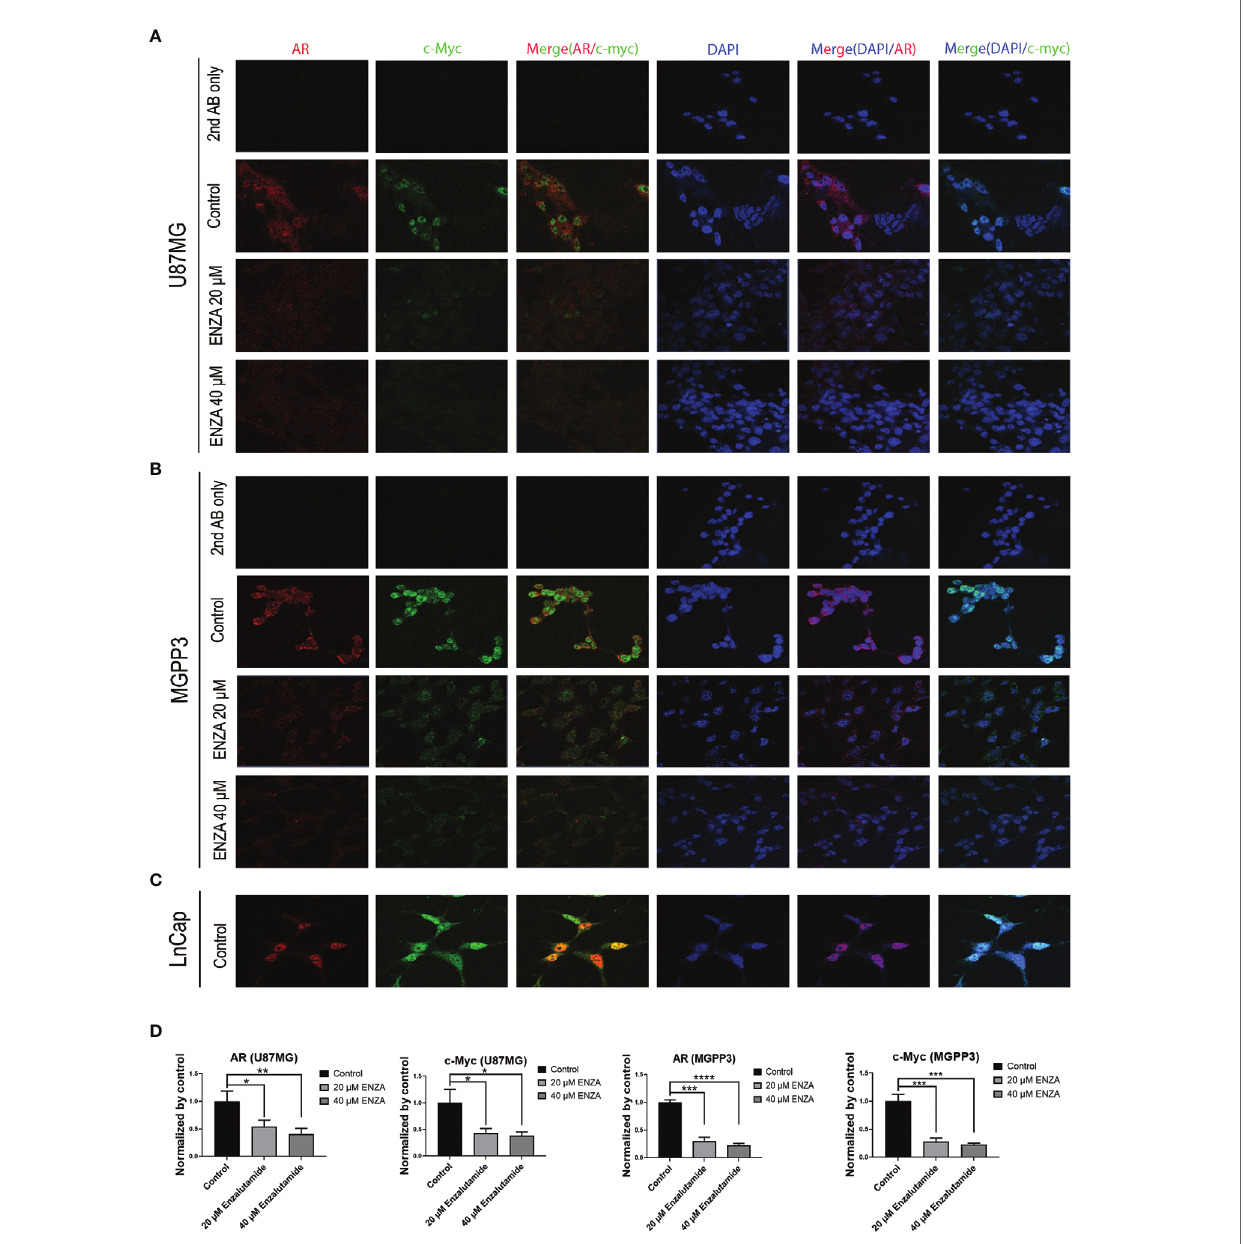
FIGURE 3 | Confocal immuno fl uorescence studies demonstrate that enzalutamide decreases AR (red) and c-Myc (green) in GBM cells cultured in vitro (U87MG and MGPP3). (A) U87MG cells were treated with DMSO (negative control) or various concentrations of enzalutamide (20 µM or 40 µM). (B) MGPP3 cells were treated with DMSO or various concentrations of enzalutamide (20 µM or 40 µM). (C) LnCap (prostate cancer cell line) served as a positive control. (D) Quanti fi cation of the immuno fl uorescence signals of AR and c-Myc in U87MG and MGPP3 cell lines after enzalutamide treatment (20 µM or 40 µM) for 24 h. *p < 0.05; **p < 0.01; ***p < 0.001; ****p <